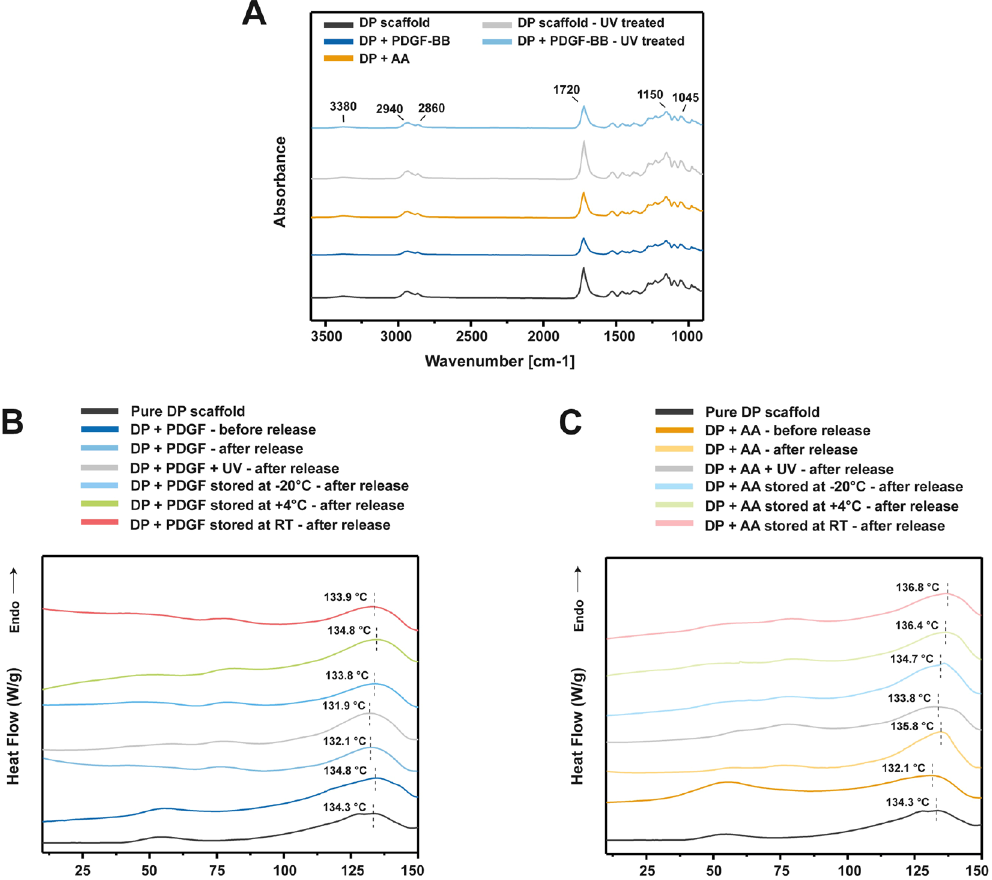
Figure 1. FTIR and DSC characterization of differently stored and UV sterilized bioactive DP scaffolds. ( A ) FTIR absorbance spectra for bioactive DP scaffolds incorporating PDGF-BB or ascorbic acid, with or without UV sterilization. ( B , C ) DSC thermograms (not to absolute scale) of first heating for non-stored, stored and UV sterilized bioactive DP scaffolds with PDGF-BB or ascorbic acid, after 30 days long in vitro release study, compared to pure DP scaffolds and bioactive scaffolds before release